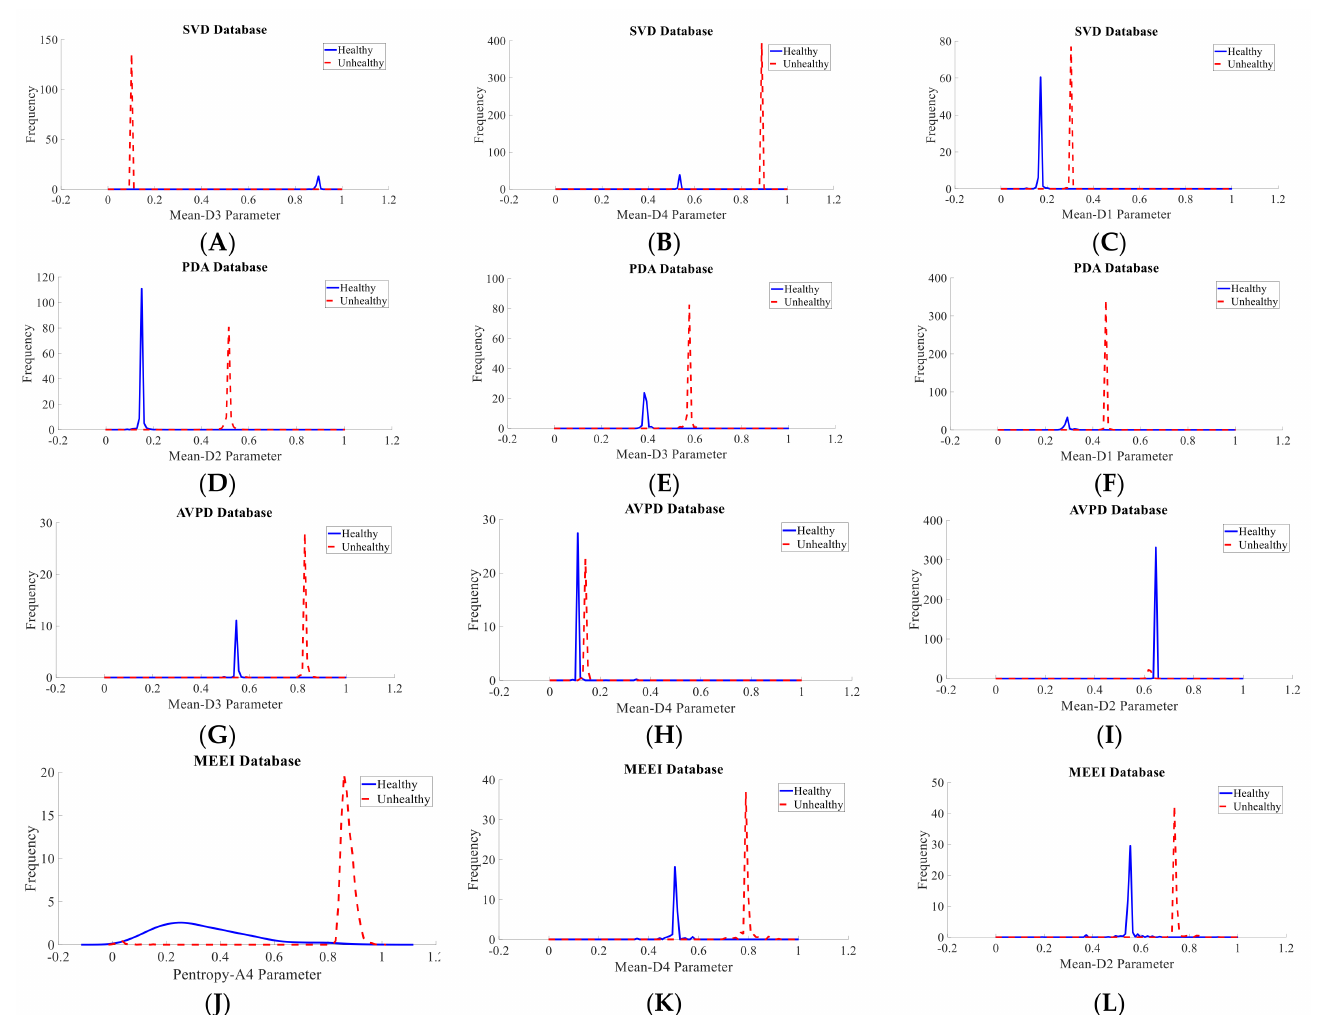
Figure 6. Density plots for the top three descriptors used in the diagnosis of voice illnesses: ( A ) Den- sity plot for Mean-D3 parameter of SVD, ( B ) Density plot for Mean-D4 parameter of SVD, ( C ) Density plot for Mean-D1 parameter of SVD, ( D ) Density plot for Mean-D2 parameter of PdA, ( E ) Density plot for Mean-D3 parameter of PdA, ( F ) Density plot for Mean-D1 parameter of PdA, ( G ) Density plot for Mean-D3 parameter of AVPD, ( H ) Density plot for Mean-D4 parameter of AVPD, ( I ) Density plot for Mean-D2 parameter of AVPD, ( J ) Density plot for Pentropy-A4 parameter of MEEI, ( K ) Density plot for Mean-D4 parameter of MEEI, ( L ) Density plot for Mean-D2 parameter of